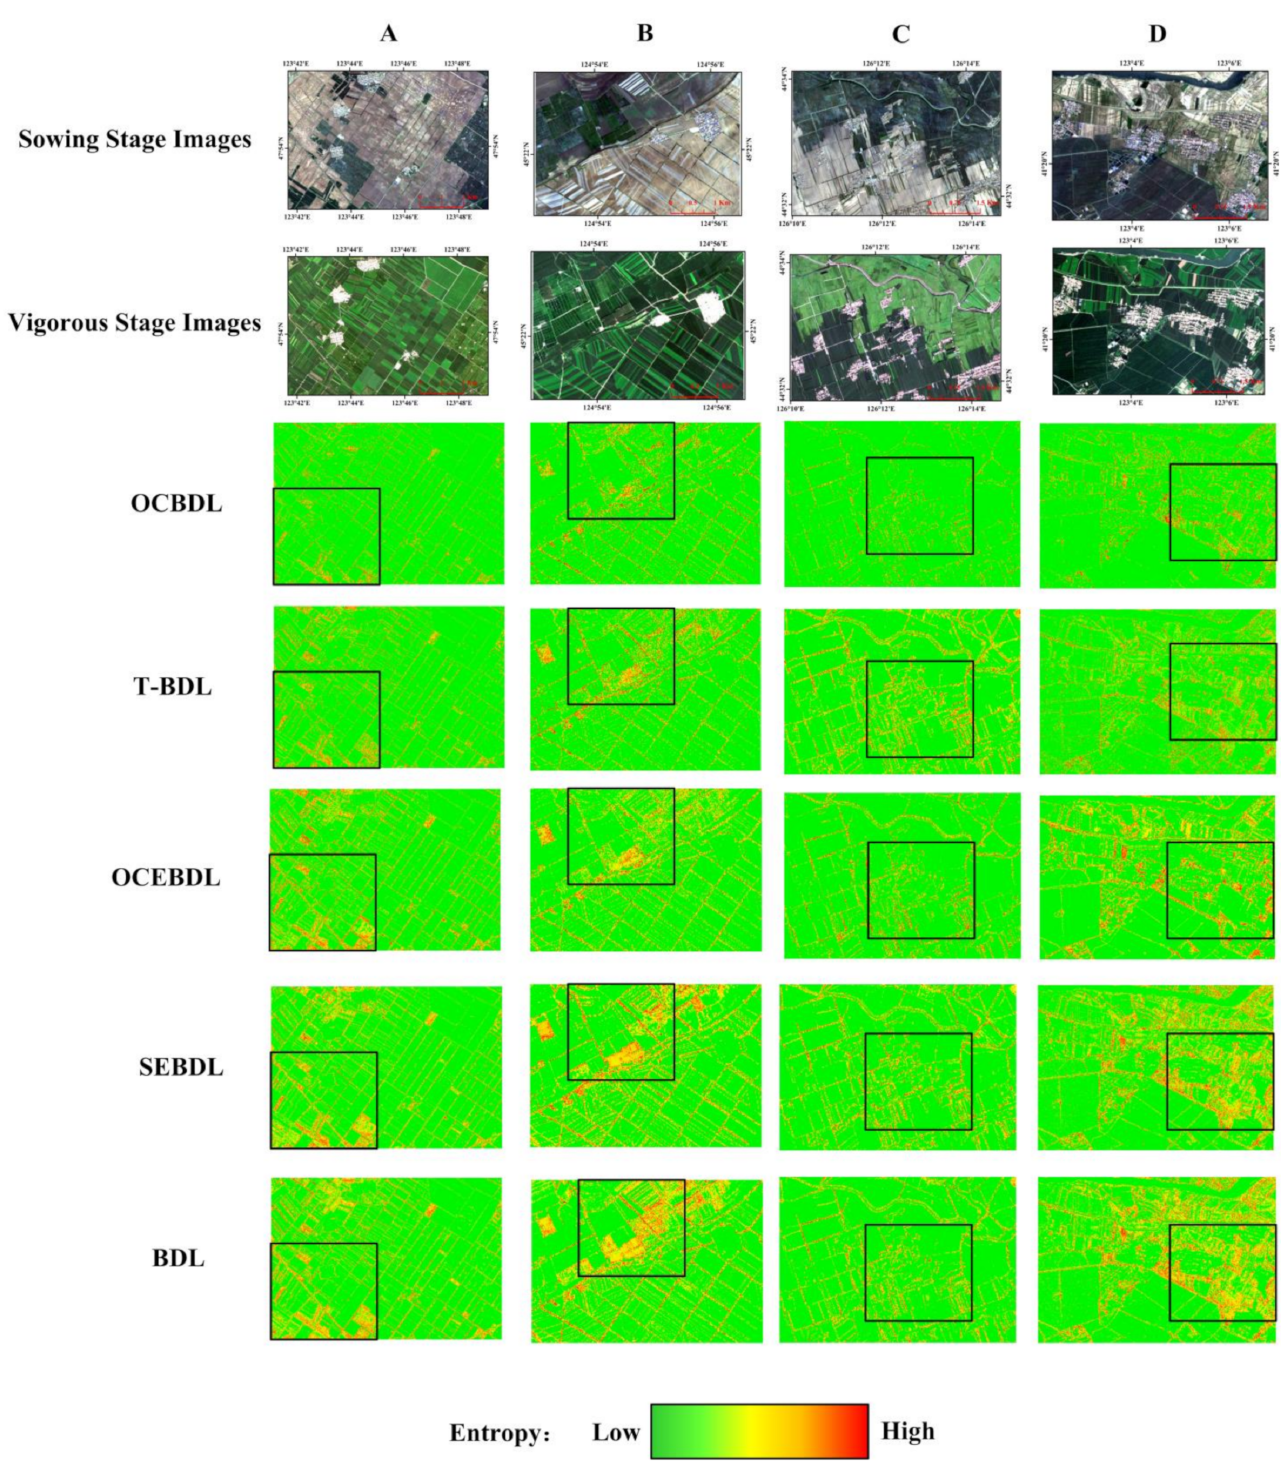
Figure 9. ( A – D ) Uncertainty distribution of the classification results of different model structures in the four test areas. The black wireframe shows the difference in